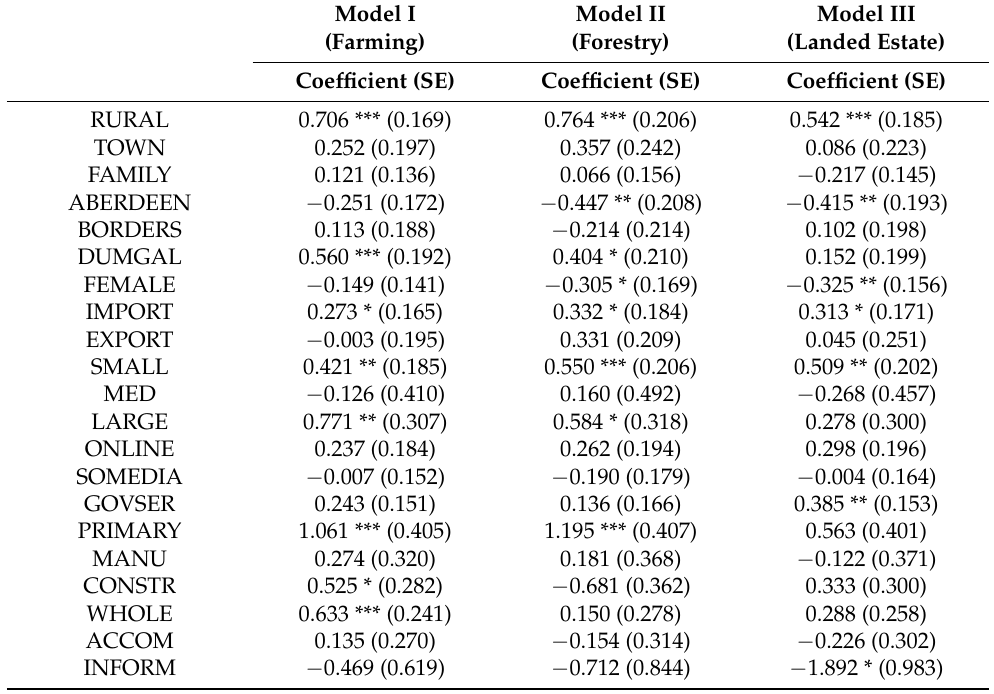
Table 2. The key determinants of the relationships between land-based sectors and non-land-based businesses in